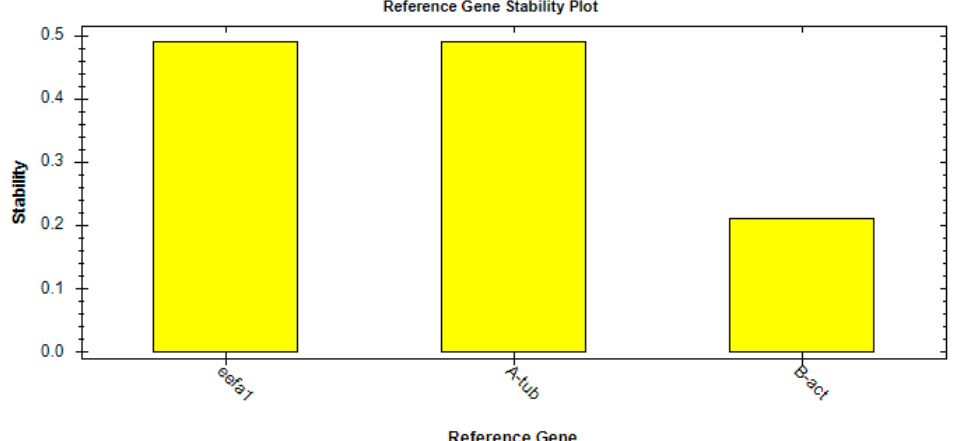
Figure 2. Results of stability analysis of the housekeeping genes eEF1a1, α -tubulin, and β -actin.